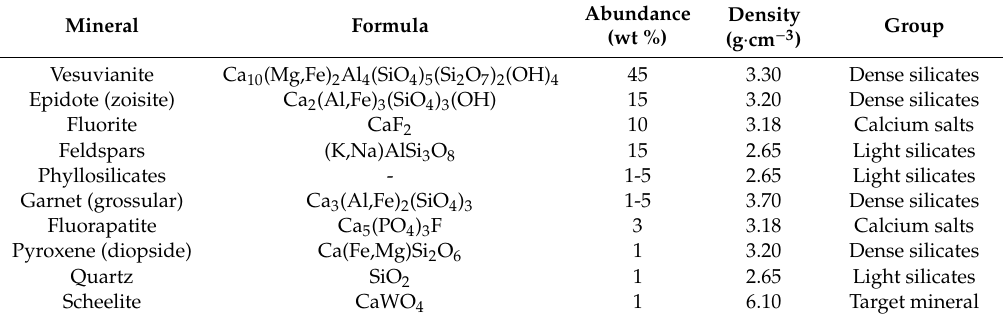
Table 1. Mineralogical composition of the Tabuaço W-skarn showing the relative abundances along with the chemical formulas, and the densities of the minerals which are classified into four di ff erent